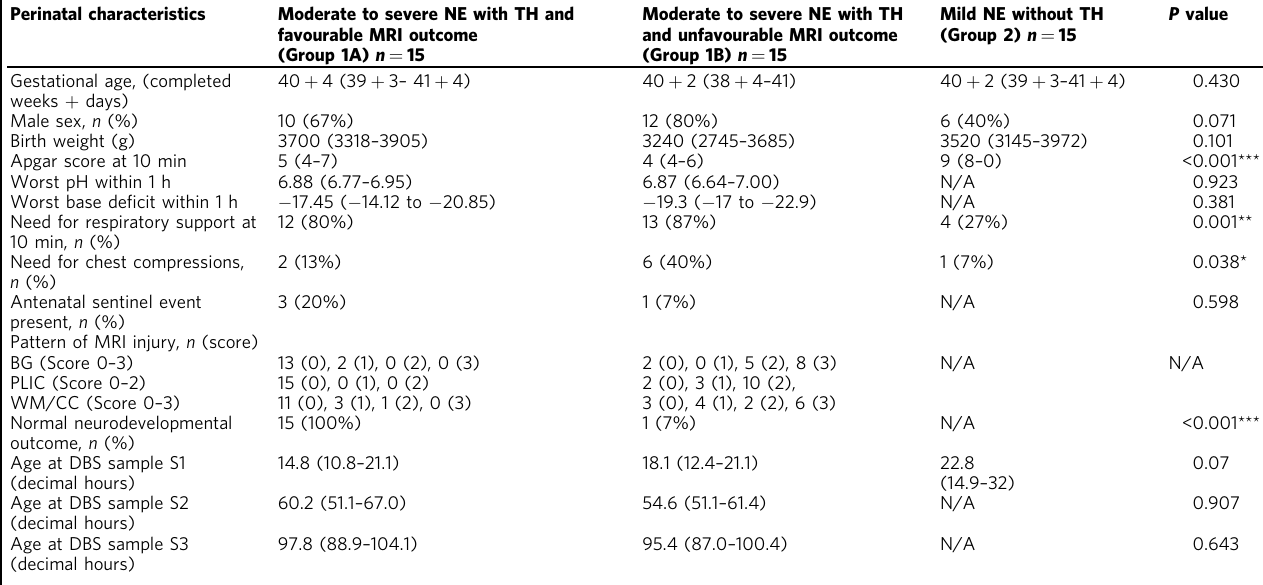
Table 1 Clinical characteristics of patient samples analysed by RT-qPCR for the validation cohort. Perinatal